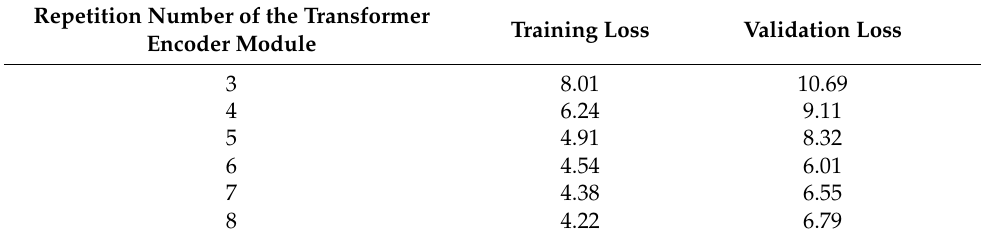
Table 1. Training and validation set loss values (TECU) when L = 3,4,5,6,7,8. Repetition Number of the